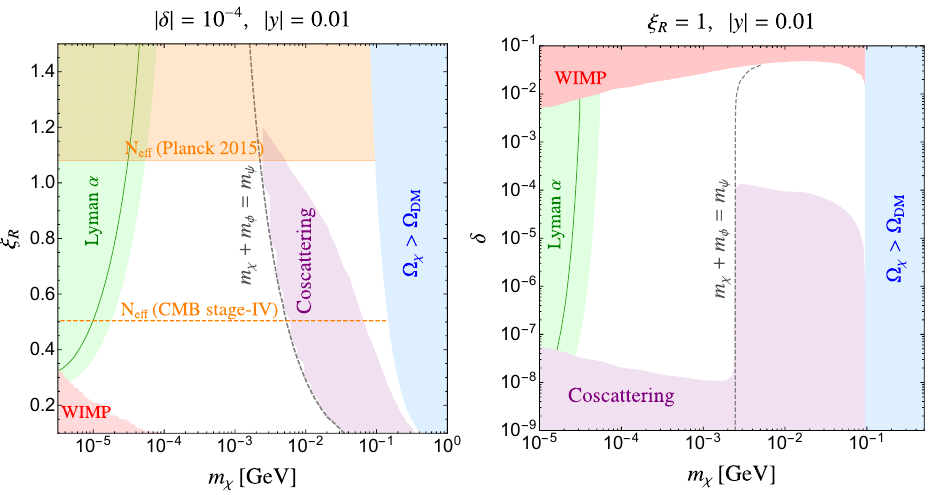
Figure 11 . Phenomenology of a dark sector decoupled from the SM, but in equilibrium with dark radiation. In the left panel we show the bound on the relative temperatures of the dark and SM sectors at reheating, (cid:24) R = T R =T R , as a function of the DM mass. We show constraints on N e(cid:11) SM dark from current Planck measurements [64] and the projected CMB Stage-4 sensitivity [101]. In the right panel we show the DM mixing angle, (cid:14) , with the active state, versus the DM mass. When the mixing is too large or small the relic density is no longer set by coannihilation. The range of allowed DM masses is determined by DM overproduction and constraints on the free-streaming length from Lyman- (cid:11) measurements [139{142]. In every point of the plot, (cid:1) is (cid:12)xed to reproduce the observed relic density. The remaining parameters are set to y = 0 : 01 e i(cid:25)= 4 , m (cid:30) = m (cid:31) = 4, and (cid:14) = 10 (cid:0) 4 e i(cid:25)= 4 ( (cid:24) R = 1) in the left ( right )